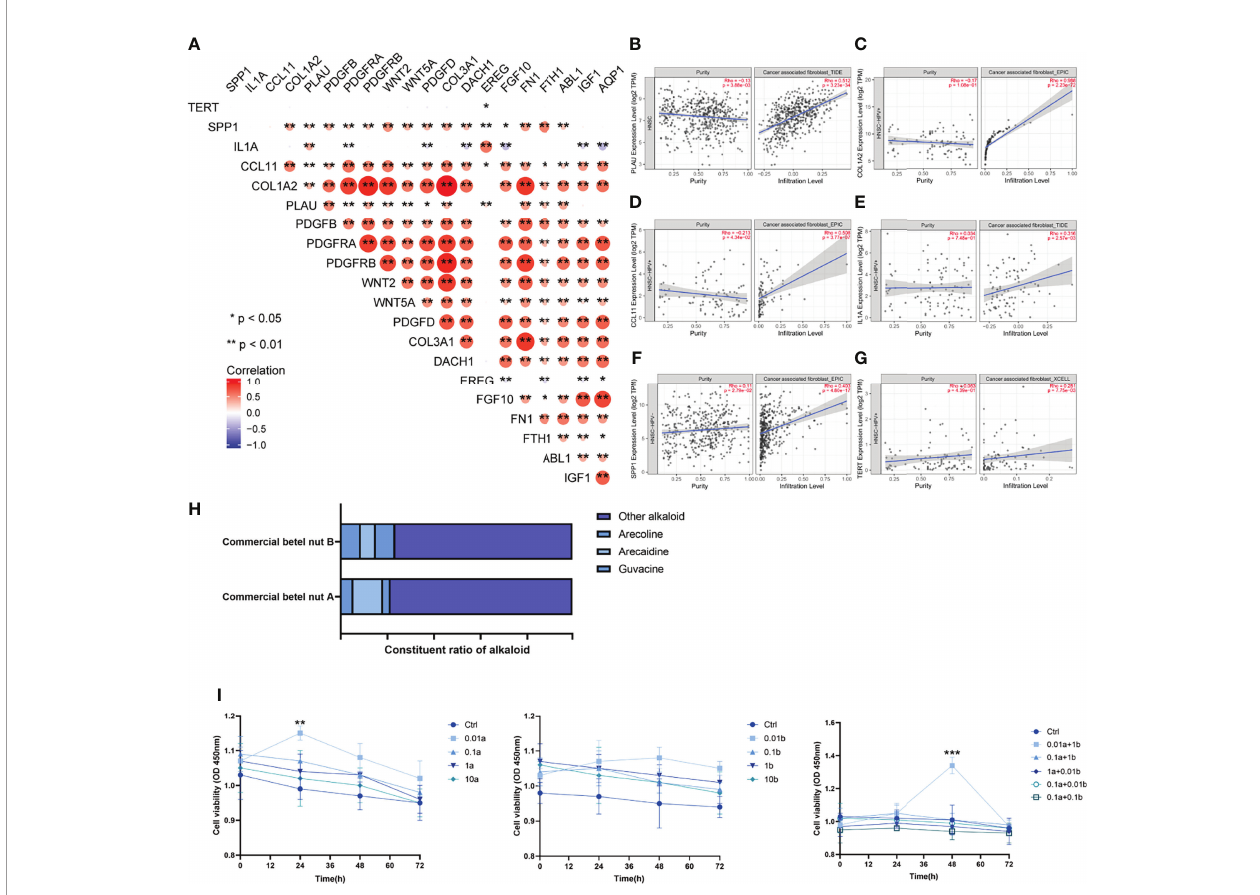
FIGURE 7 | Correlation between arecoline-associated OSCC and CAFs. (A) Heatmap shows the correlation between AFOC-DEGs and characteristic genes associated with CAFs; Spearman ’ s correlation analyses were used to analyze the correlations (n = 328, *p < 0.05; **p < 0.01). (B) The correlation between PLAU and CAF in fi ltration; the correlation analysis was done by TIMER2.0 (n = 522, rho = 0.512, p < 0.001). (C) The correlation between COL1A2 and CAF in fi ltration; the correlation analysis was done by TIMER2.0 (n = 98, rho = 0.988, p < 0.001). (D) The correlation between CCL11 and CAF in fi ltration; the correlation analysis was done by TIMER2.0 (n = 98, rho = 0.508, p < 0.001). (E) The correlation between IL1A and CAF in fi ltration; the correlation analysis was done by TIMER2.0 (n = 98, rho = 0.316, p = 0.003). (F) The correlation between SPP1 and CAF in fi ltration; the correlation analysis was done by TIMER2.0 (n = 422, rho = 0.403, p < 0.001). (G) The correlation between TERT and CAF in fi ltration; the correlation analysis was done by TIMER2.0 (n = 98, rho = 0.281, p = 0.008). (H) Effects of arecoline stimulation on cell viability; a refers to arecoline, and b refers to arecaidine; all experiments were performed in three repetitions; a t-test was used to analyze the data (**p < 0.01; ***p < 0.001). (I) Commercial betel nut composition diagram shows that arecoline and arecaidine are the main alkaloids in betel nut. OSCC, oral squamous cell carcinoma; CAFs, cancer-associated